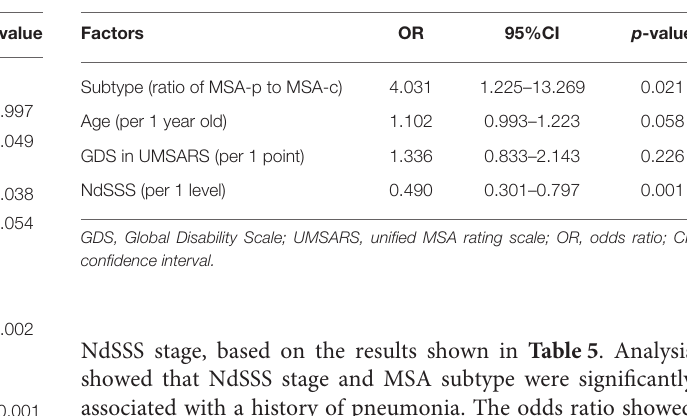
TABLE 5 | Difference in clinical information and NdSSS stage by history of pneumonia in patients with multiple system atrophy.